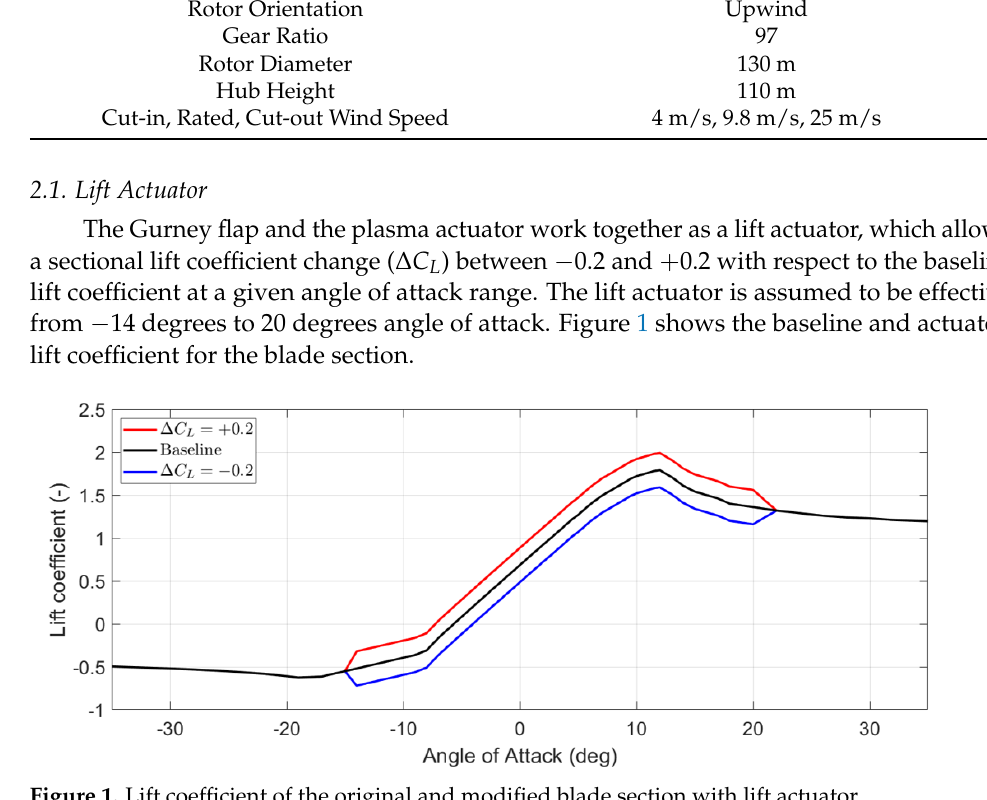
Figure 1. Lift coefficient of the original and modified blade section with lift actuator.